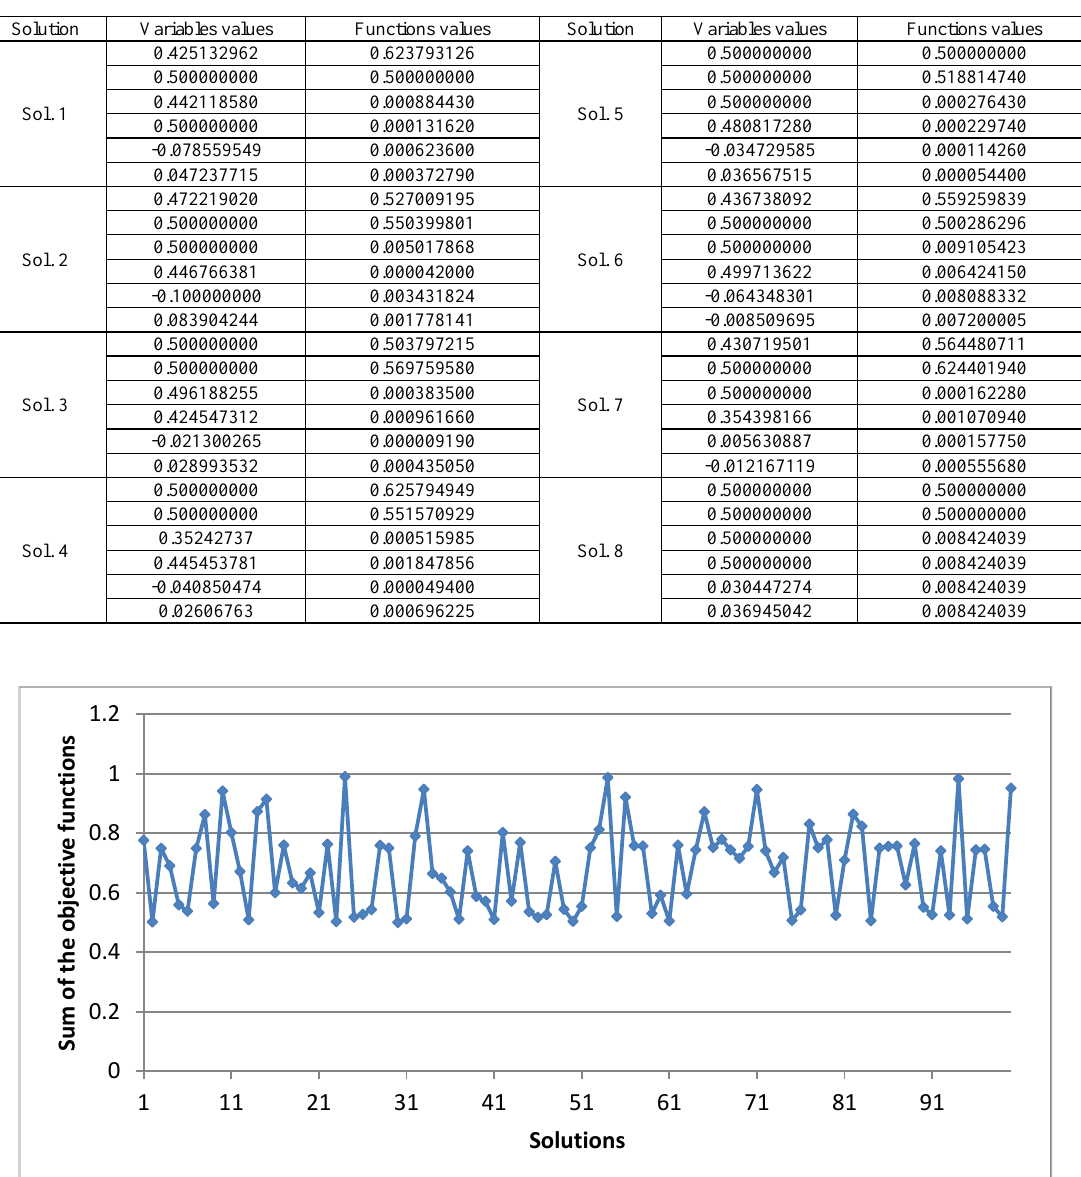
Table 6. Examples of nondominated solution obtained by MOPSO for neurophysiology application problem